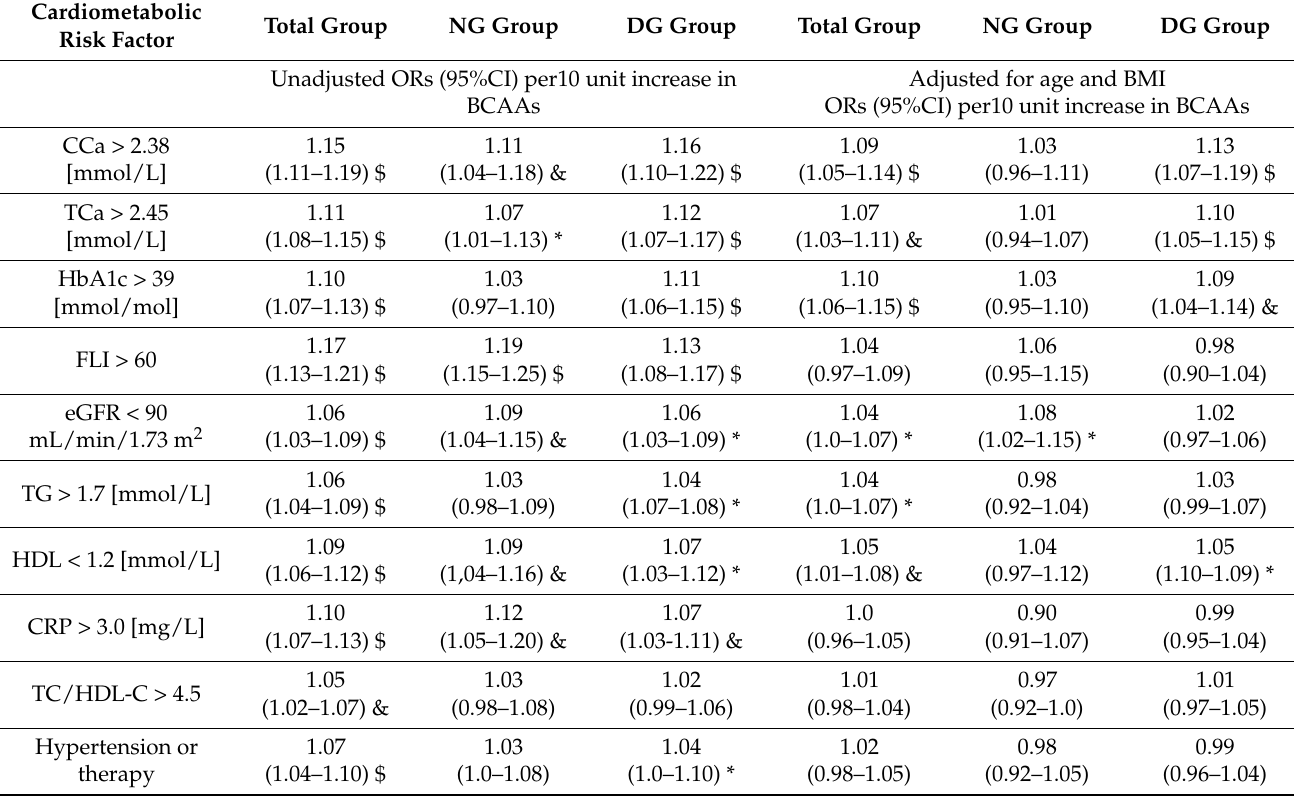
Table 3. Associations of BCAAs with cardiometabolic risk factors in logistic regression models. Cardiometabolic Risk